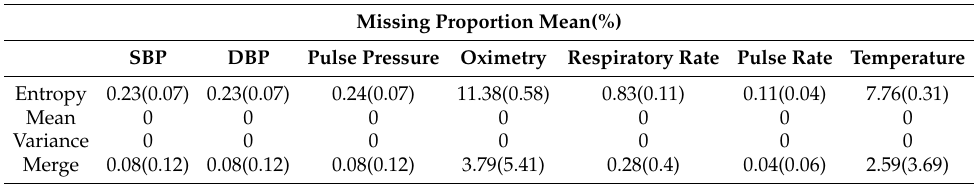
Table 3. Missing data analysis in vital